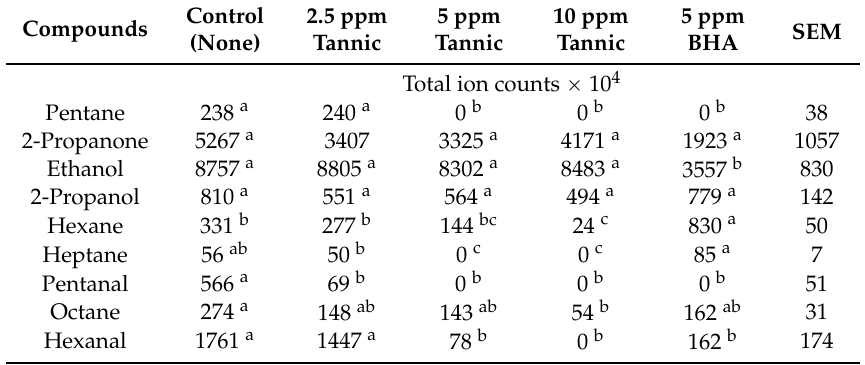
Table 4. Volatile profiles of cooked chicken breast meat with different level of tannic acid at day 0. Compounds